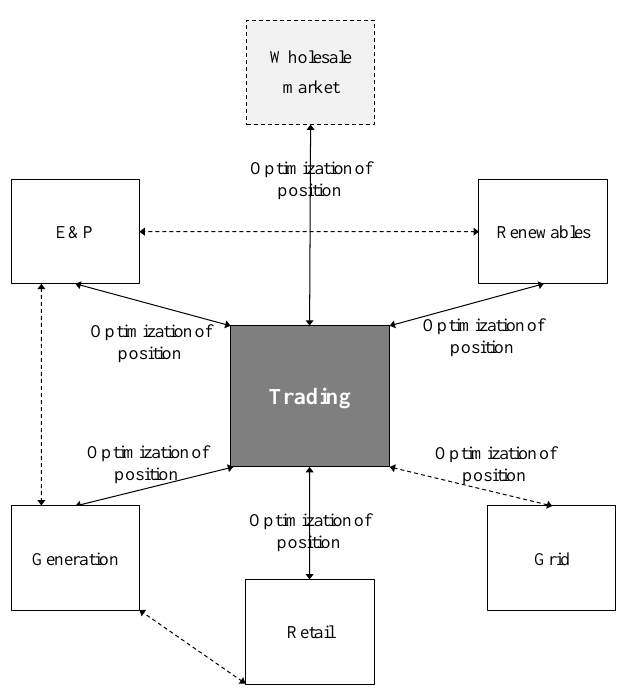
Figure 16. Illustration of synergy cluster “CAO”. Own illustration, based on RWE internal information.